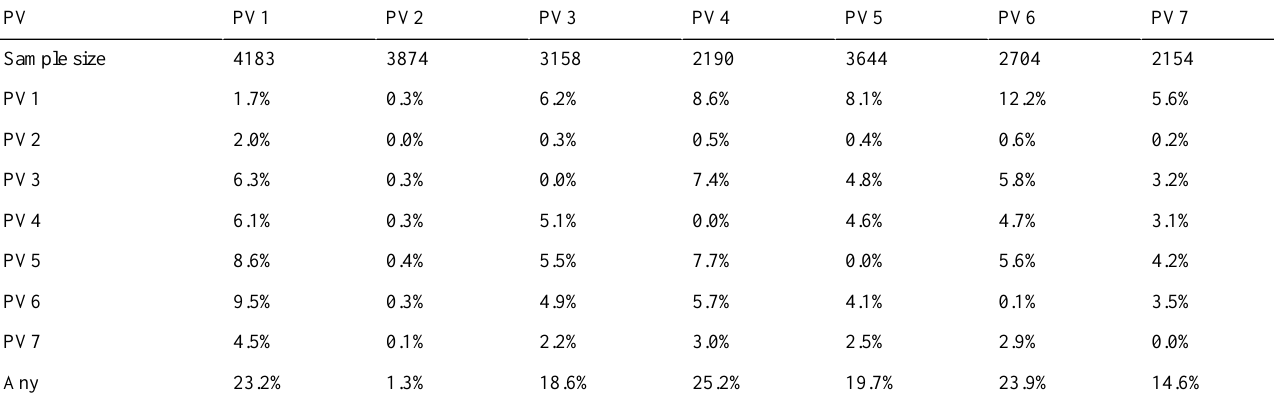
Table 1. Overlap a within and between panel vendors